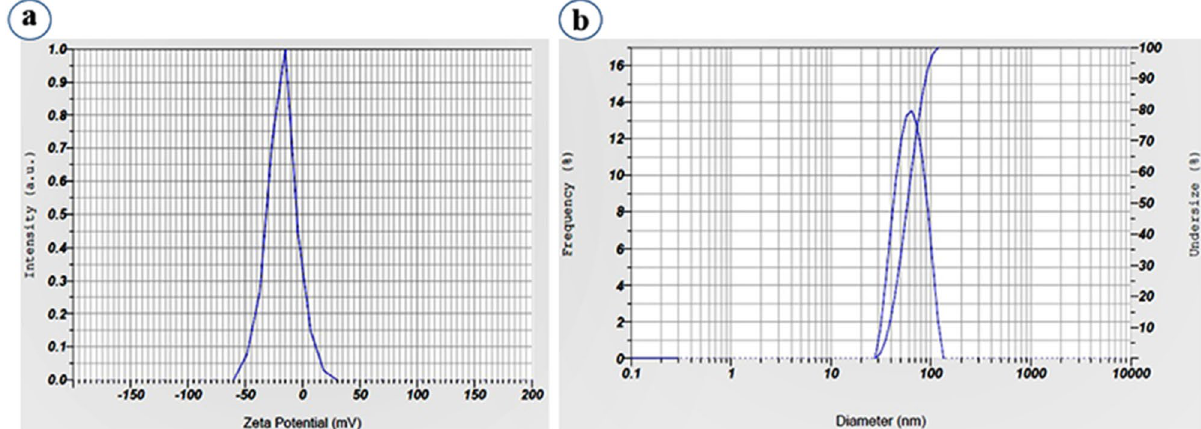
Figure 4. Zeta potential spectra measurements of biosynthesized Pf-AgNPs ( a ), and size distribution analysis of Pf-AgNPs ( b ).